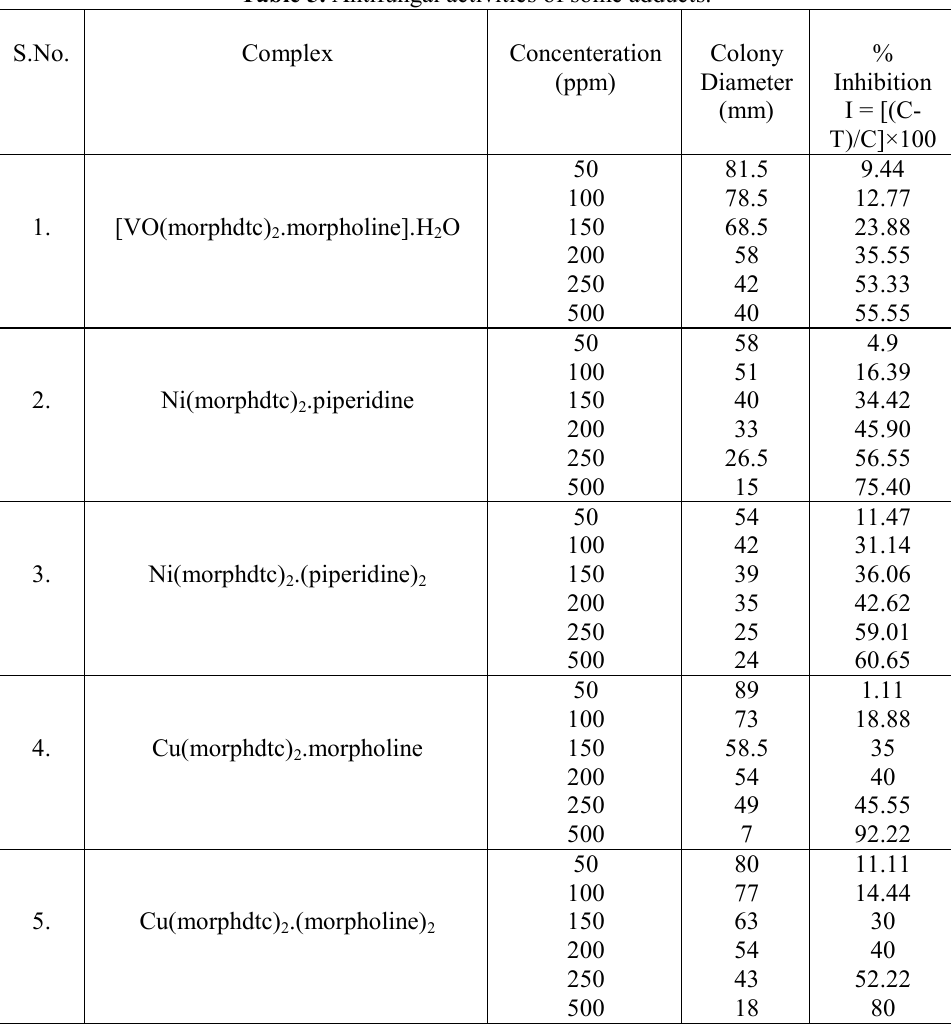
Table 5. Antifungal activities of some